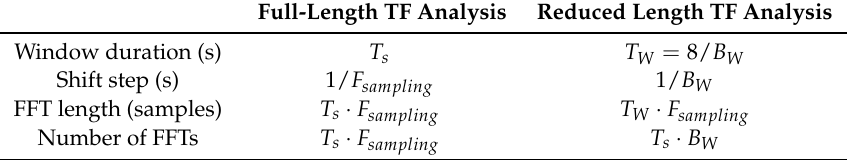
Table 1. Comparison of the parameters of the STFT of the current signal using the traditional full-length analysis and the proposed reduced length TF analysis, where T s is the length of the current signal, F sampling is the sampling frequency and T W and B W are the parameters of the Slepian window obtained from Equation (27).